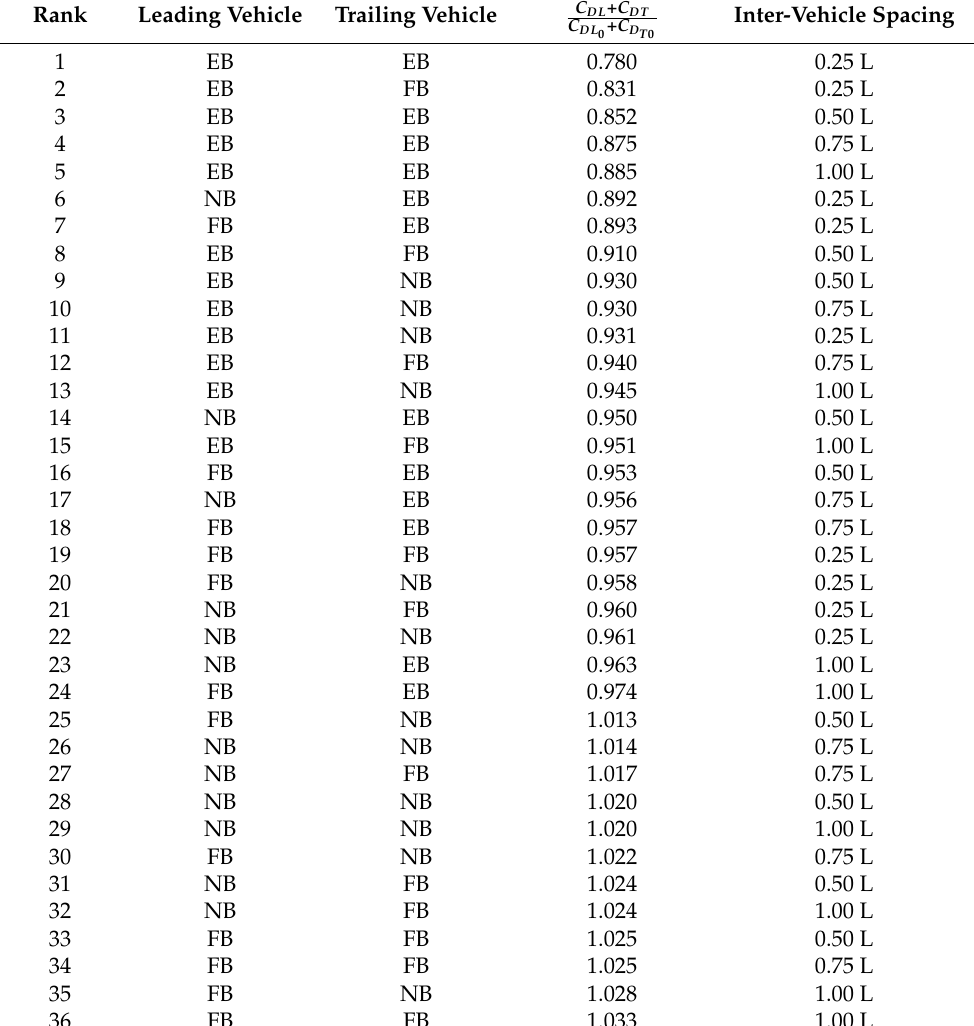
Table 3. Summary of the platoon drag ratios normalised against the baseline results of each vehicle ranked to represent the most favourable combinations. C DL is the drag coefficient of the leading vehicle in platoon, C DT is the drag coefficient of the trailing vehicle in platoon and C DL the leading and trailing vehicles drag coefficient in isolation respectively. Rank Leading Vehicle Trailing